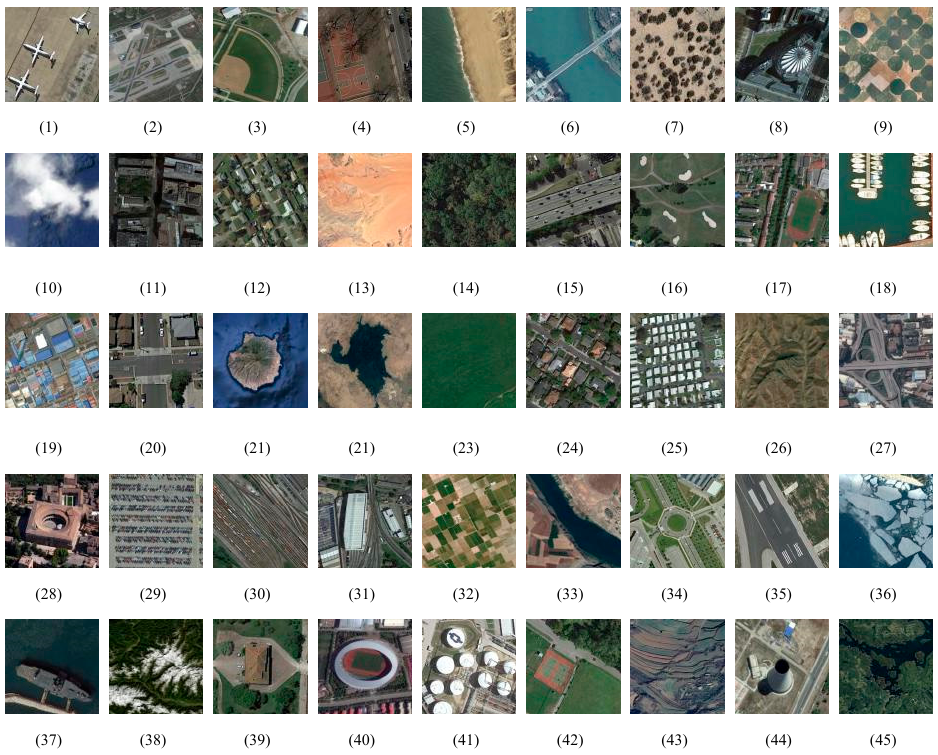
Figure 4. Example images of NWPU-RESISC45 dataset: (1) airplane; (2) airport; (3) baseball diamond; (4) basketball court; (5) beach; (6) bridge; (7) chaparral; (8) church; (9) circular farmland; (10) cloud; (11) commercial area; (12) dense residential; (13) desert; (14) forest; (15) freeway; (16) golf course; (17) ground track field; (18) harbor; (19) industrial area; (20) intersection; (21) island; (22) lake; (23) meadow; (24) medium residential; (25) mobile home park; (26) mountain; (27) overpass; (28) palace; (29) parking lot; (30) railway; (31) railway station; (32) rectangular farmland; (33) river; (34) roundabout; (35) runway; (36) sea ice; (37) ship; (38) snow berg; (39) sparse residential; (40) stadium; (41) storage tank; (42) tennis court; (43) terrace; (44) thermal power station; and (45)